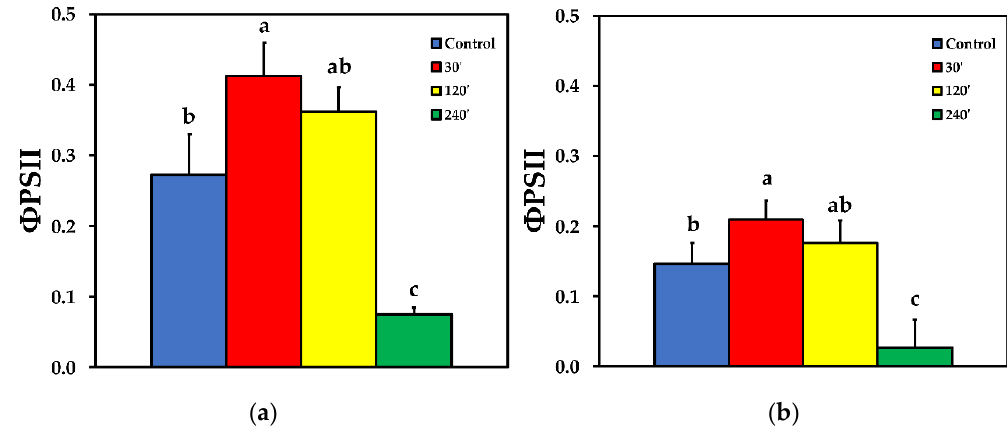
Figure 2. The effective quantum yield of PSII photochemistry ( Φ PSII ) before (control) and after 30, 120 and 240 min of B. cinerea aquatic spore suspension application on tomato leaflets, measured at 230 µ mol photons m − 2 s − 1 ( a ), and at 900 µ mol photons m − 2 s − 1 ( b ). Error bars are standard deviations (n = 6). Columns with different letters are statistically different ( p < 0.05).